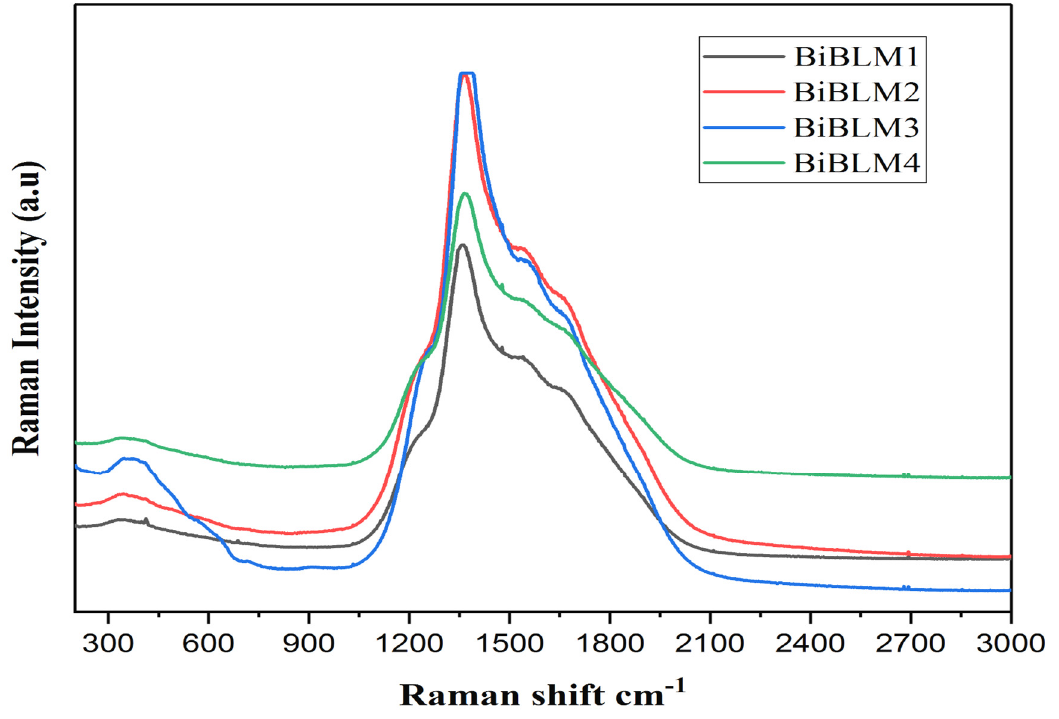
Table 4. Raman band assignment of BiBLM glasses.